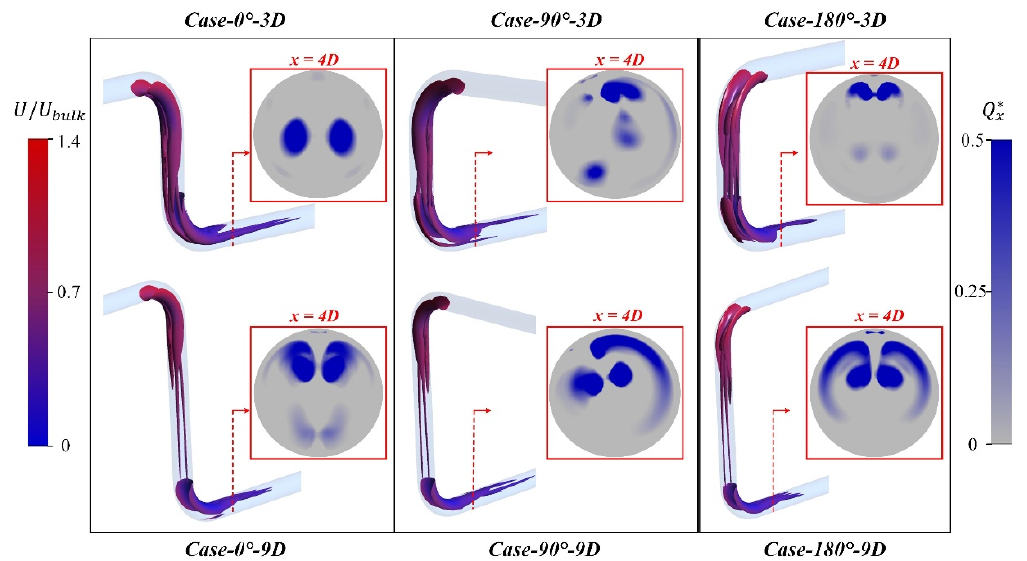
Figure 14. Vortex structures in Case-0°-3D , Case-90°-3D , Case-180°-3D , Case-0°-9D , Case-90°-9D , and Case18-0°-9D .